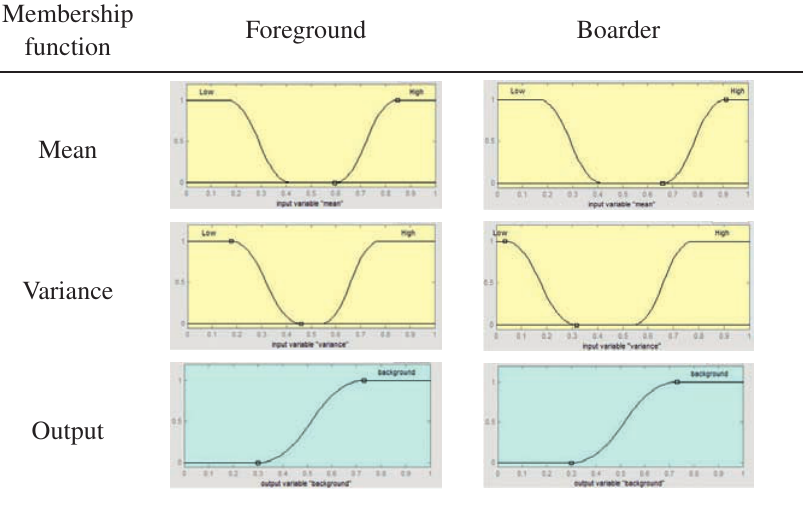
Table 2. Fuzzy memberships functions employed for local level